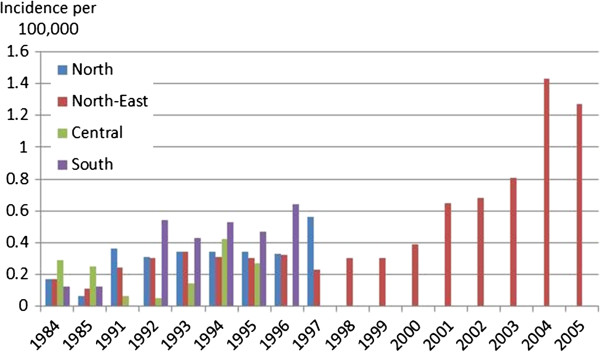
Incidence of diabetes mellitus type 1 in children aged 0-15. Sources [22-26]:. Secondary results from Tuchinda et al. 2002. Notes: Results from a study in Bangkok were not included as they were not comparable with the other studies due to the different methodology employed [24]. There was another study looking at the seasonal variation in DMT1 which was not included because it did not report incidence rates but only total number of cases in one hospital which made it unsuitable to calculate population incidence rates [20]. Incidence was calculated by dividing the total number of cases reported by hospitals with the total child population in the hospitals’ catchment area. Data were obtained from retrospective postal survey or medical record analysis and no information on the diagnostic criteria used was provided. A study summarising the results of the regional studies mentions that the criteria in the 1997 Report of the Expert Committee on the Diagnosis and Classification of Diabetes Mellitus were used.